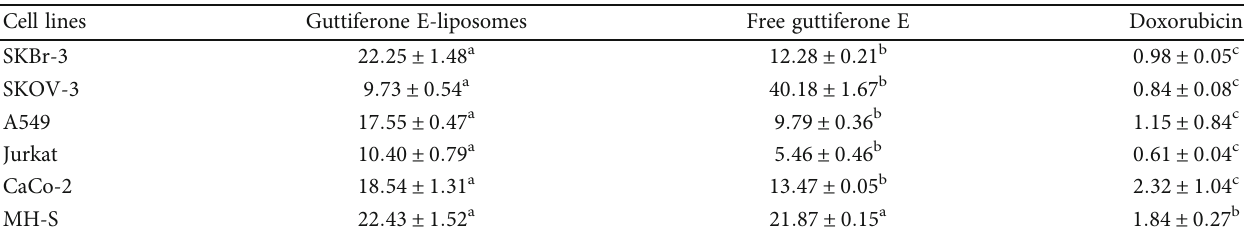
Data represent the mean ± SD of three independent experiments. Within each row, values with di ff erent letters are signi fi cantly di ff erent at p < 0 : 0001 , according to Dunnett ’ s multiple comparisons test using two-way